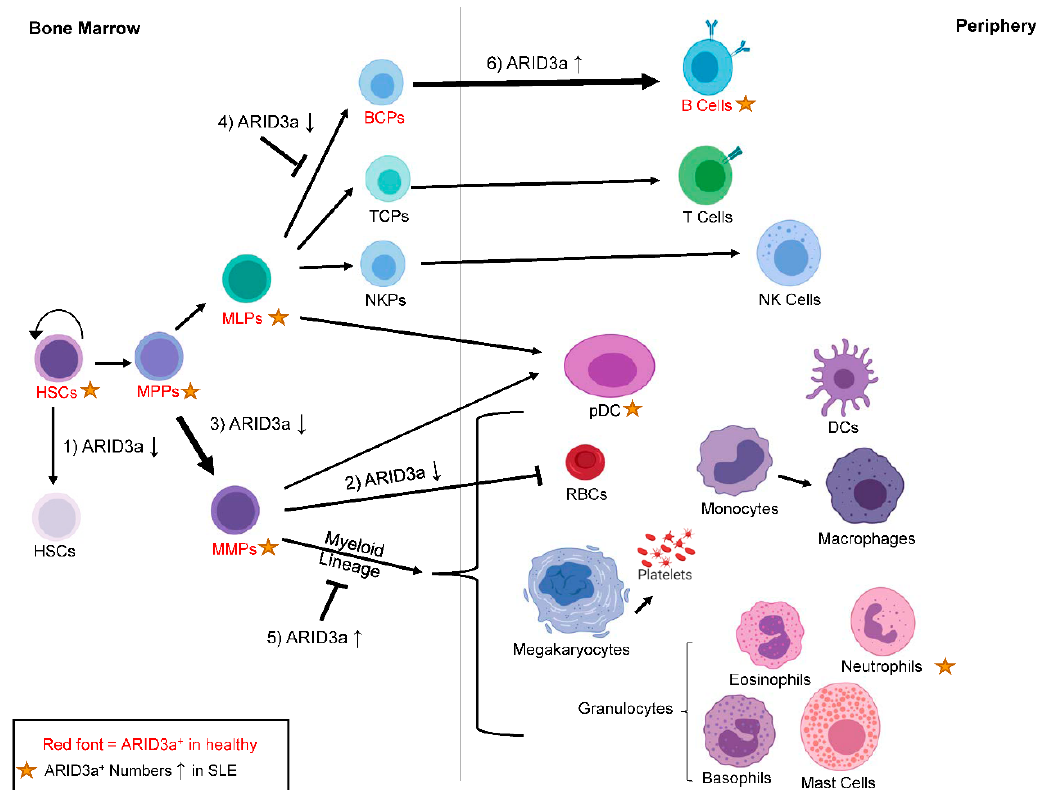
Figure 4. ARID3a is expressed in healthy and SLE hematopoietic progenitors, and the levels of ARID3a affect lineage decisions . Cell subsets with ARID3a expression in healthy individuals are indicated with the red font, while gold stars indicate populations with increased numbers of ARID3a-expressing cells in SLE patients. The effects of increased or inhibited levels of ARID3a (arrows up or down) on HSCs ( 1 ), RBCs ( 2 ) early myeloid lineage development ( 3 ), early B lymphoid development ( 4 ), late myeloid lineage development ( 5 ), and late B lineage development ( 6 ) are shown by thicker arrows for increases, or with a symbol showing that development is blocked. HSCs—hematopoietic stem cells; MPPs—multipotent progenitors; MMPs—multi-myeloid progenitors; MLPs—multi-lymphoid progenitors; TCPs—T cell progenitors; NKPs—natural killer cell progenitors; pDCs—plasmacytoid dendritic cells; RBCs—red blood cells.